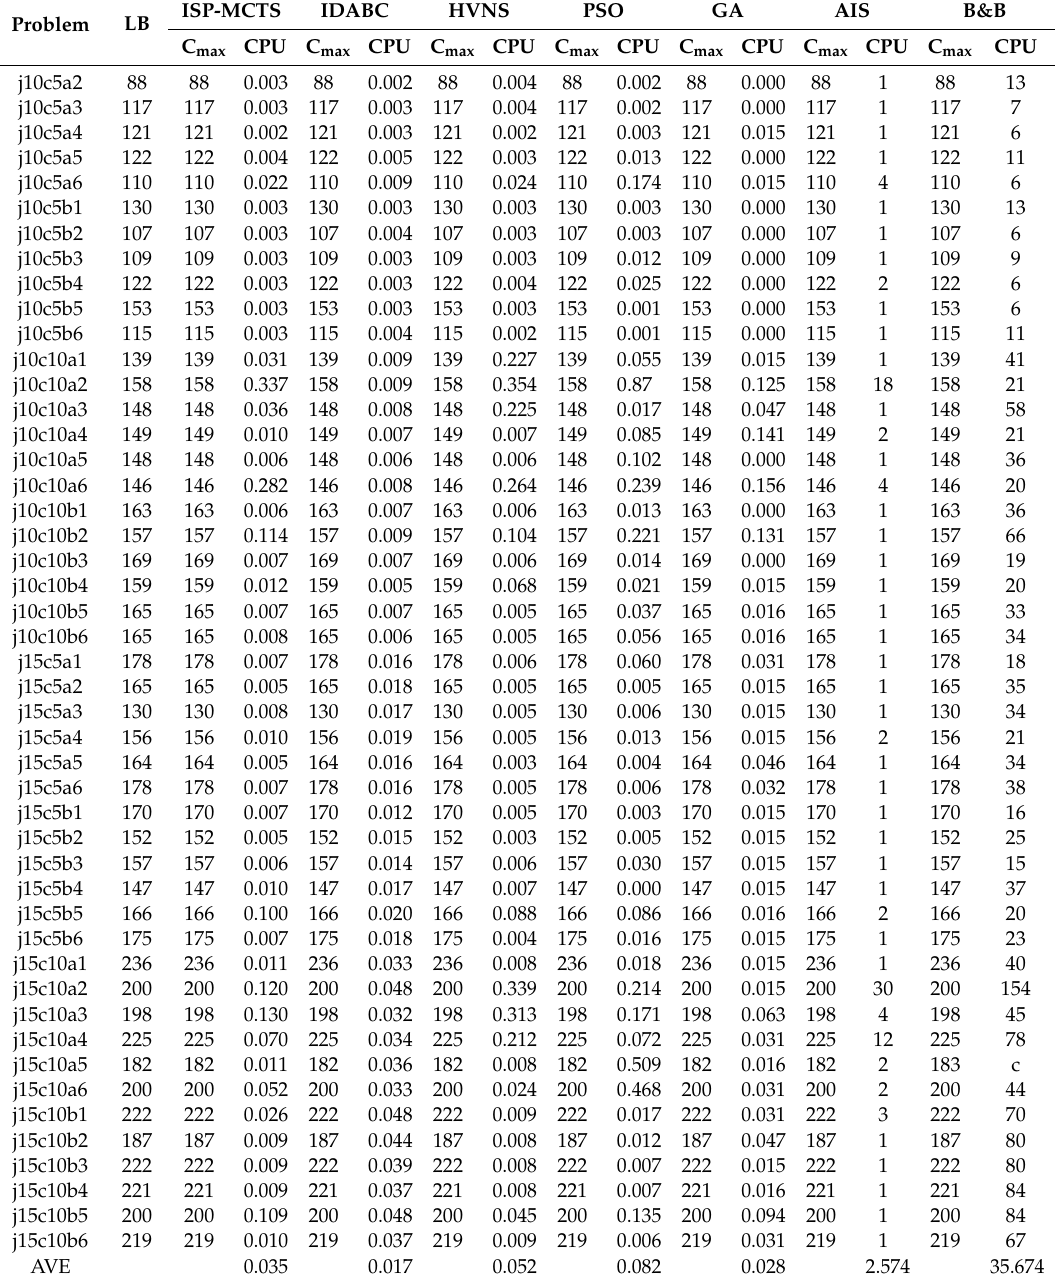
Table 4. Comparison results for the type a and type b